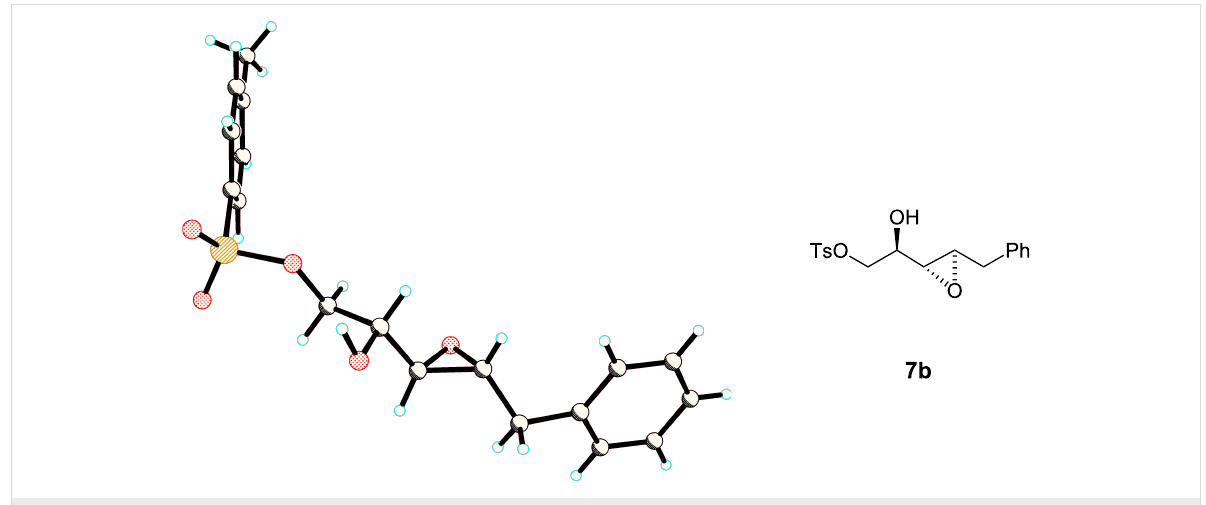
respectively [15]. The excess of alkene favours the cross meta- thesis reaction and the products were obtained in good yields predominantly as the ( E )-isomer. It was not possible to separate the minor ( Z )-isomer at this stage, however isomer separation was more readily achieved after the subsequent epoxidation step. Thus ( S )- 4 and ( S )- 5 were subjected to epoxidation reac- tions following Sharpless’ methodology [16]. The anti -epoxy alcohols were easily generated, however it proved more diffi- cult to prepare the syn -epoxides cleanly. Treatment with titanium isopropoxide (Ti(OiPr) 4 ) and D-diisopropyl tartrate (D-DIPT) favoured formation of the anti -α,β-epoxy alcohols. In the case of 4 , epoxide 6b was obtained in 80% yield and in 97:3 dr. For 5 , the resulting epoxide 7b was generated as the only observable diastereoisomer. Epoxide (2 R ,3 R ,4 R )- 7b was recrys- tallised from diethyl ether to afford a suitable crystal for